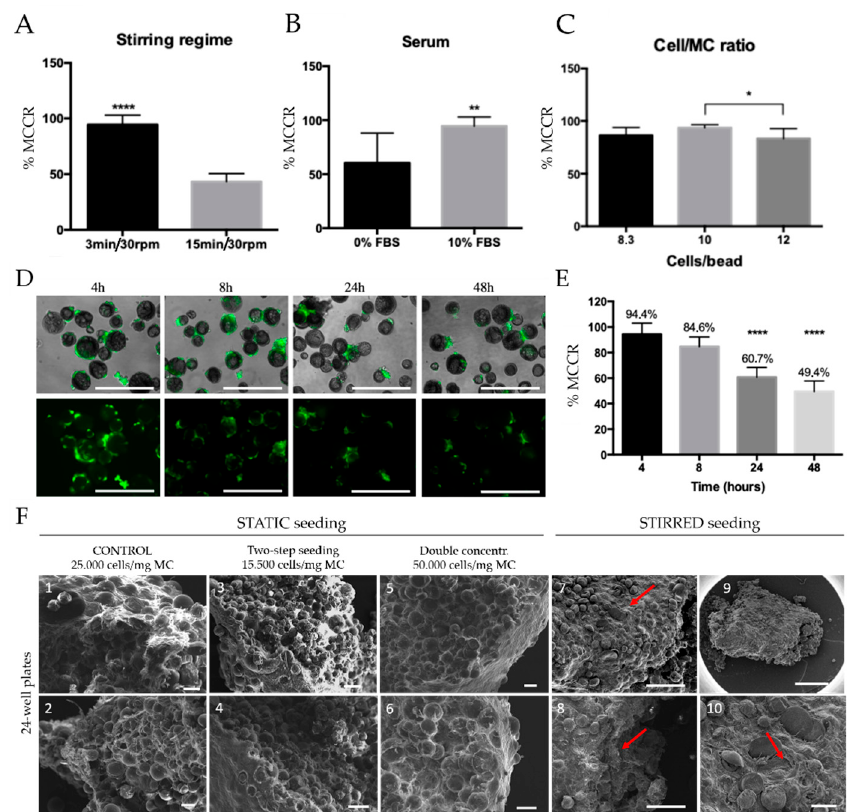
Figure 3. MT fabrication and optimization under dynamic conditions. ( A ) Dynamic MC colonization, stirring regime evaluation, scale bars = 500 μ m, ( B ) serum content, scale bars = 500 μ m, ( C ) cell/MC ratio, scale bars = 500 μ m, and ( D ) cell seeding time on MCs, scale bars = 500 μ m, alive cells in green, dead cells in red. ( E ) Dynamic MCs colonization (% particle colonization). ( F ) MT morphological comparison through SEM imaging of static vs. dynamic MCs colonization. Arrows point at homogenous cell distribution along MTs. Scale bars: Static conditions = 100 μ m; dynamic conditions = 400 μ m (7), 200 μ m (8), 1000 μ m (9), 100 μ m (10). * p- value ≤ 0.05. Arrowheads pointing deposited ECM, ** p- value ≤ 0.01, **** p -value ≤ 0.0001.